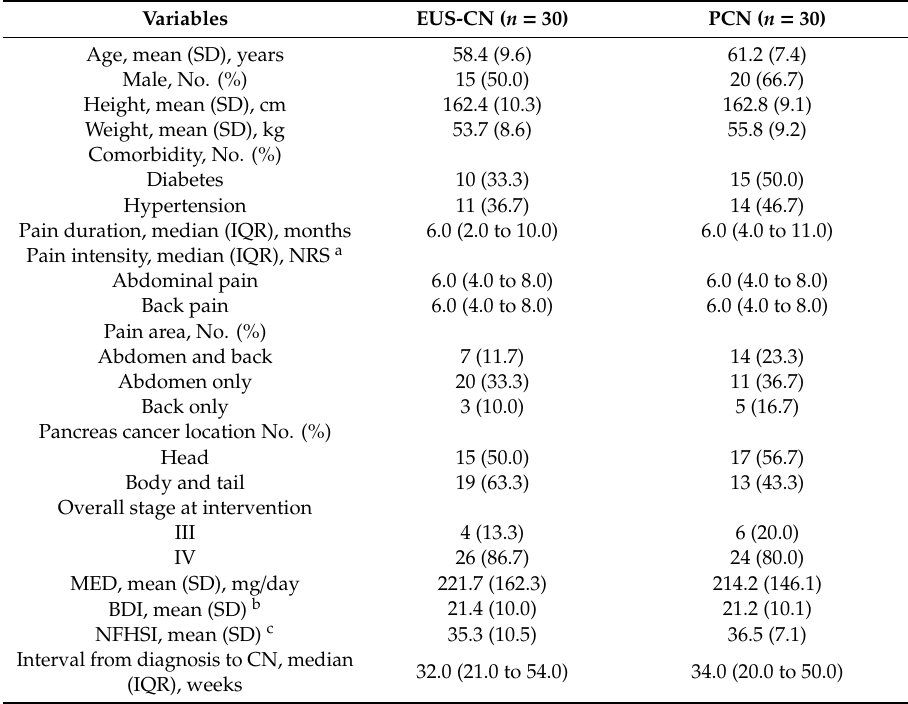
Table 1. Patient demographics and clinical characteristics.